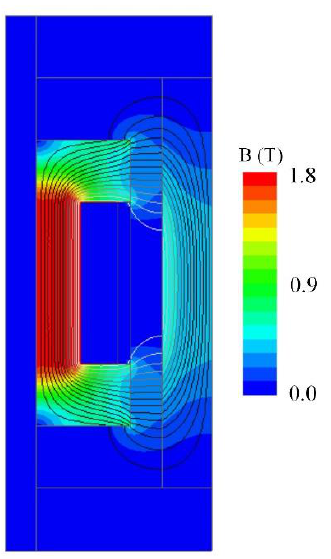
Figure 6. Magnetic field distribution of the MR buffer.